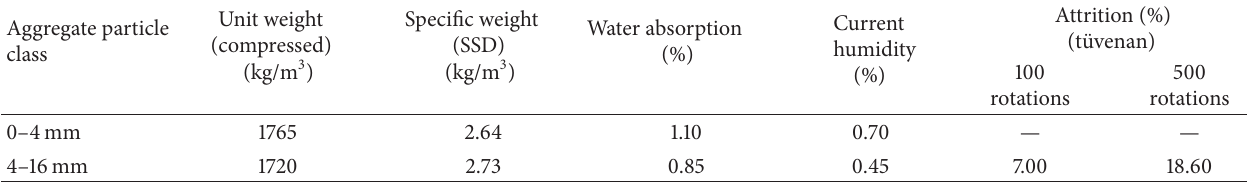
Table 4: Physical properties of aggregate used in